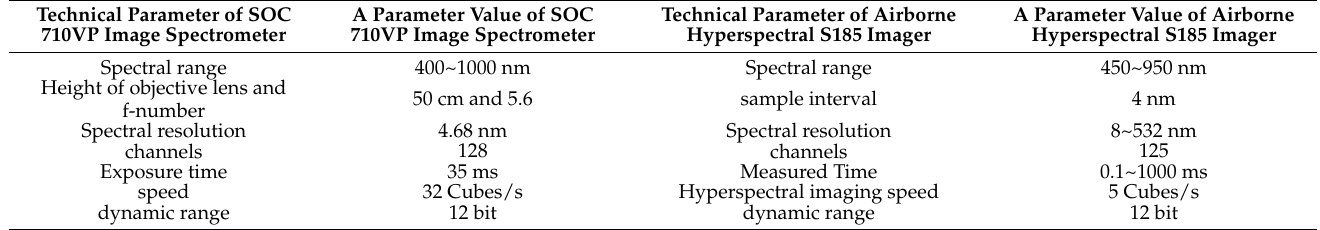
Table 2. Detailed technical parameters of SOC 710VP image spectrometer and airborne hyperspectral S185 imager.